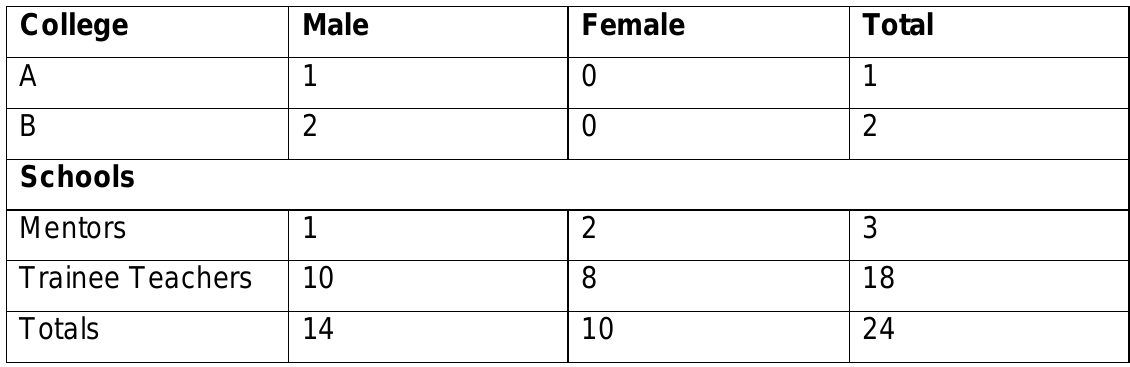
Table 3.5: Selected